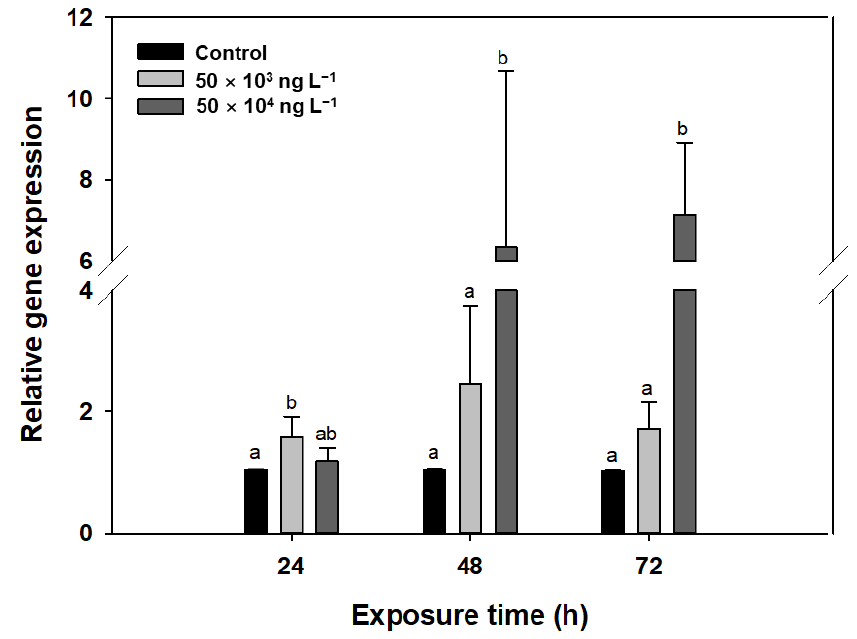
Figure 5. Relative rbcL expression in Lemna minor under diuron stress. L. minor was exposed to different concentrations of diuron (50 × 10 3 and 50 × 10 4 ng L −1 ). Data are the means of three replicates (± standard deviation). Different letters indicate statistically significant differences at p < 0.05 (one-way ANOVA, LSD).